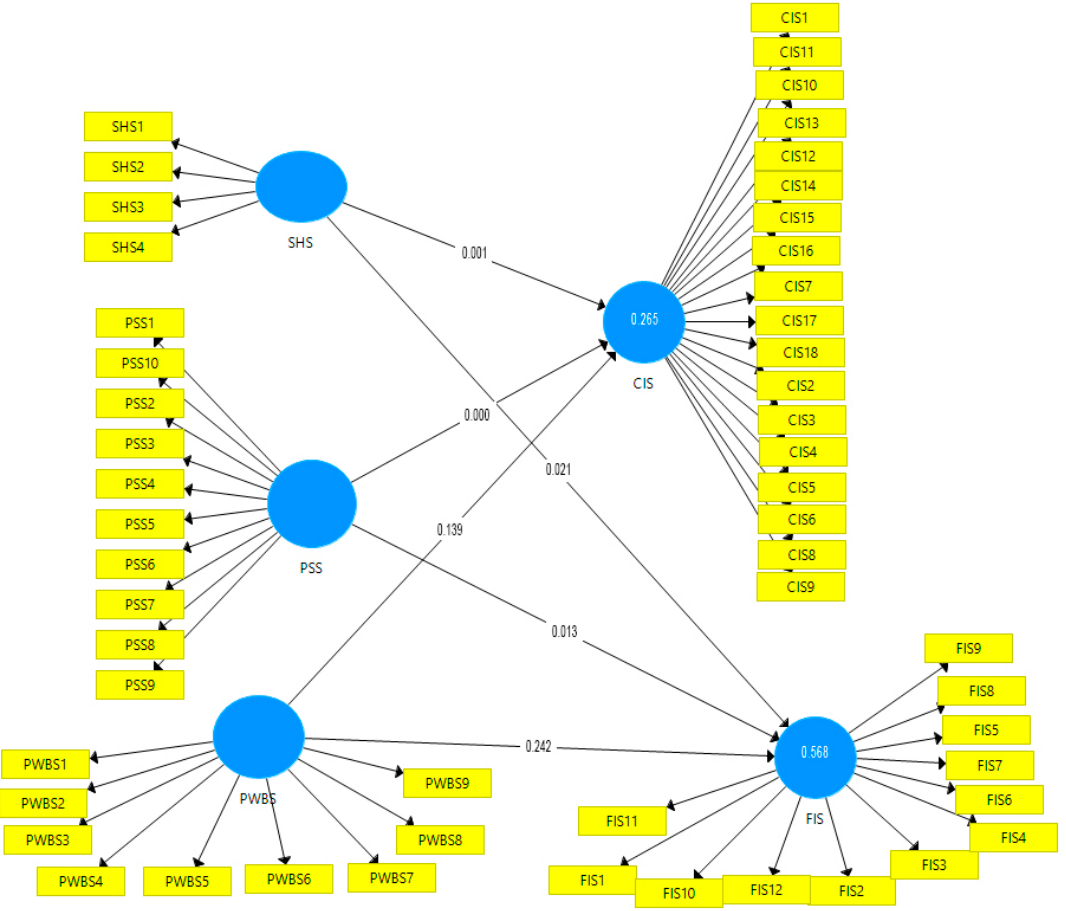
Figure 1. PLS model showing the values of R 2 and the effect size (f 2 ). SHS: subjective happiness, PSS: perceived stress, PWBS: personal well-being, CIS: current intentions to conserve water, FIS: future intentions to conserve water.